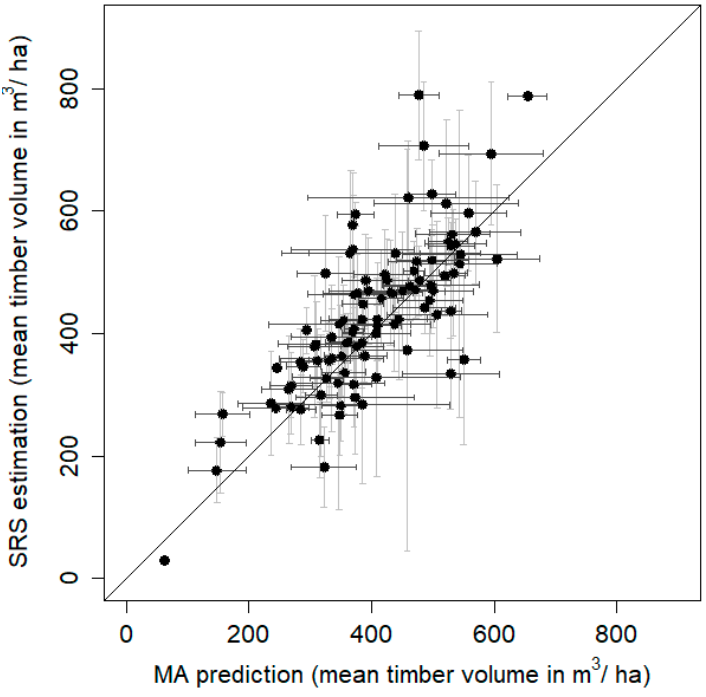
Figure 6. Mean timber volume (m 3 / ha) of 100 forest departments estimated using simple random sampling (SRS) and forest inventory plots ( y -axis), and model assisted (MA) predictions using the non-linear logistic regression model ( x -axis). Horizontal lines are MA based standard errors, and vertical lines are SRS standard errors.